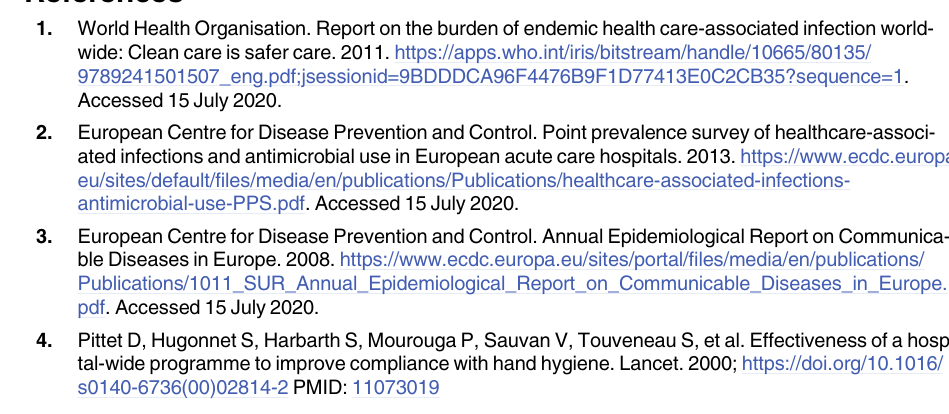
S2 Table. Coefficients for the TDF path models with the parameter for environmental con- text and resources fixed to zero. Note . β = standardized coefficient, SE = standard error; z = β /SE , p = probability value, LL = lower limit, UP = upper